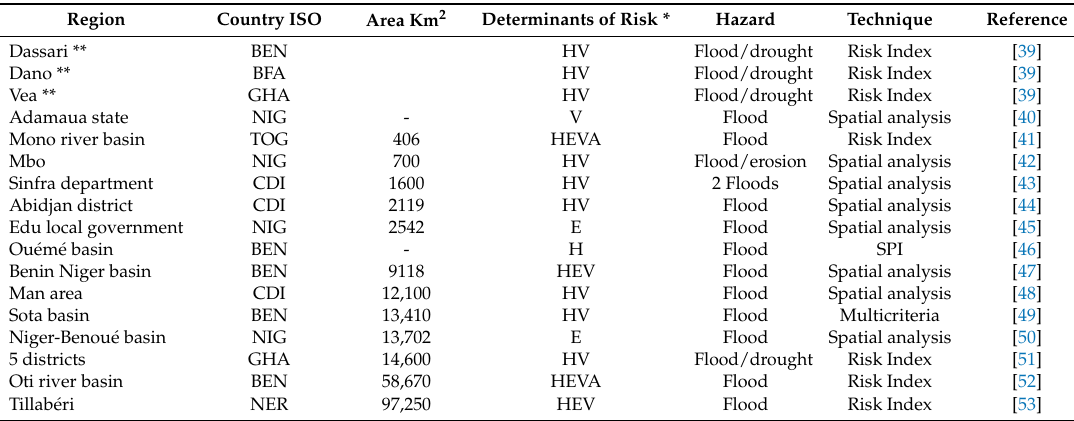
Region Country ISO Area Km 2 Determinants of Risk * Hazard Technique